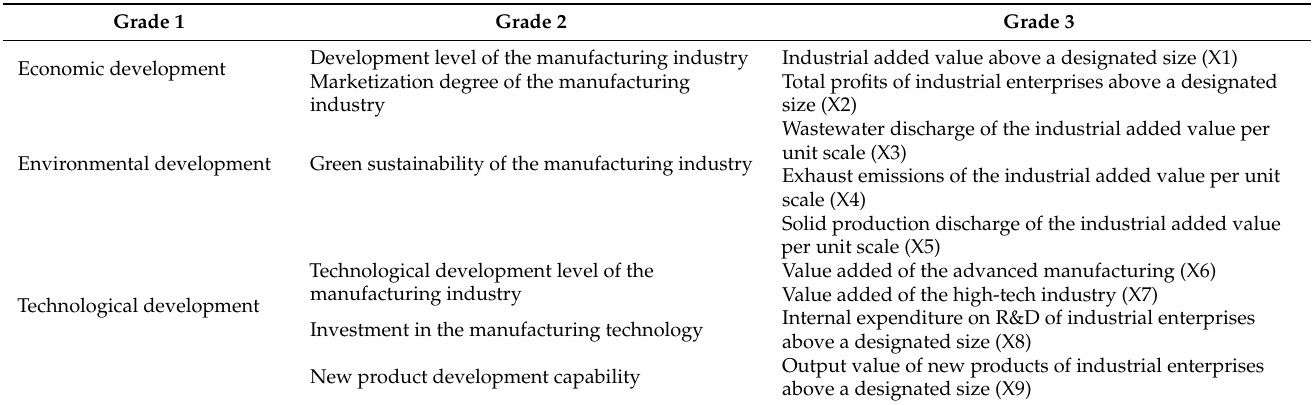
Table 1. Evaluation system for a regional